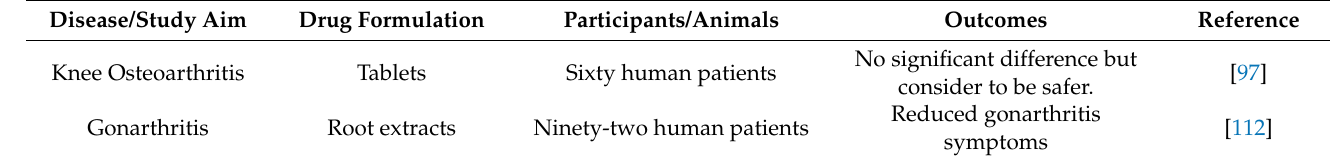
Table 3. Clinical studies of Harpagophytum